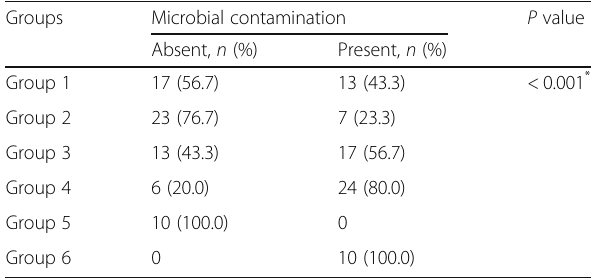
Table 1 Comparison of microbial contamination between the different study groups at the baseline phase